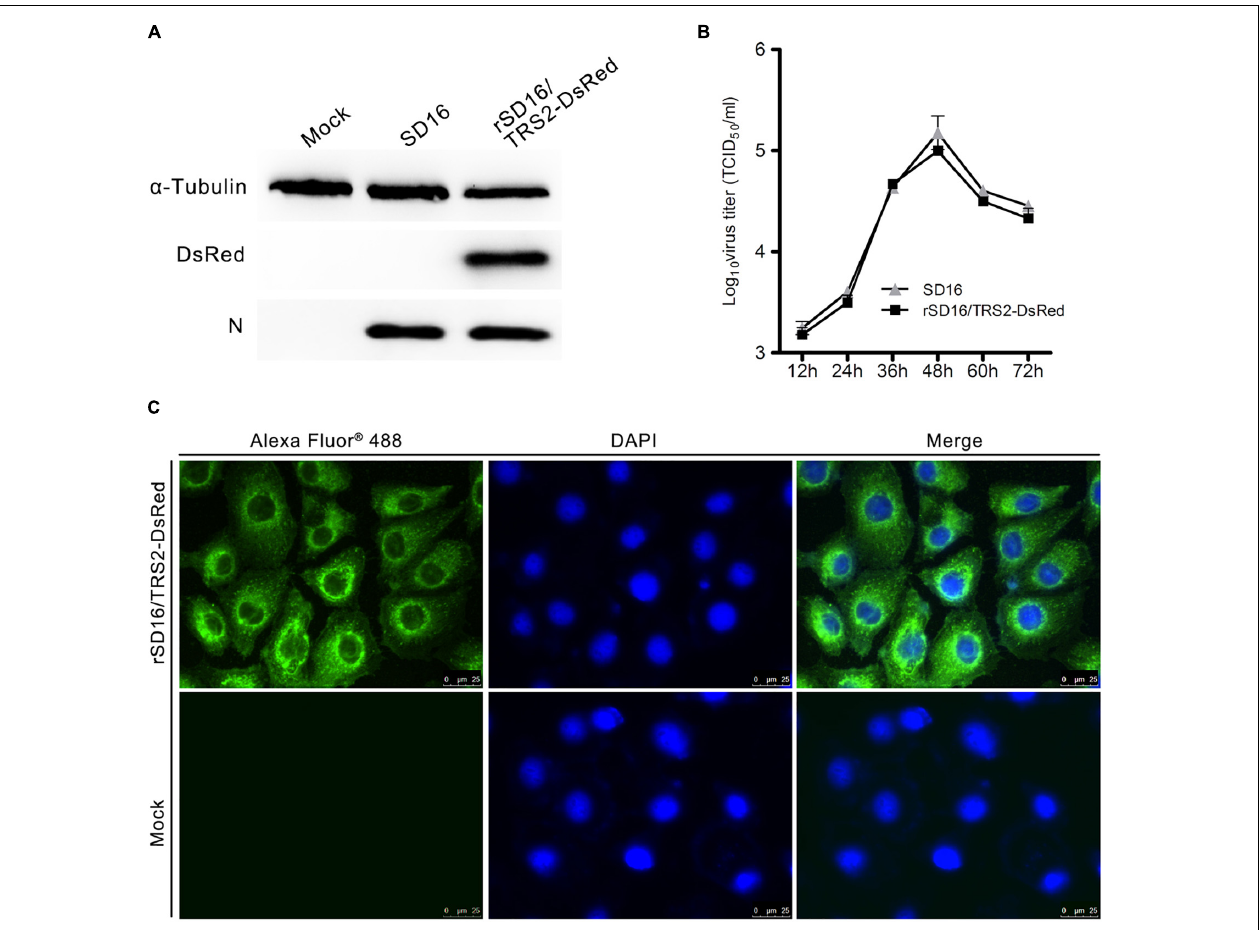
FIGURE 2 | DsRed protein expression and growth curve of rSD16/TRS2-DsRed. (A) After being infected with SD16 or rSD16/TRS2-DsRed (MOI of 0.1) for 36 h, the MARC-145 cells were lysed for the western blot analysis of PRRSV protein and DsRed expression, the MARC-145 cells infected with SD16 and normal MARC-145 cells were taken as the control; (B) MARC-145 cells were infected with SD16 or rSD16/TRS2-DsRed at the MOI of 1.0, and the progeny virus produced in the culture medium was measured at a series of times from 12 to 72 hpi by the method of TCID 50 detection, and all the data were expressed as the mean ± standard deviation (SD); (C) after infected with rSD16/TRS2-DsRed for 48 h, the MARC-145 cells were fixed for the immunofluorescence analysis using the monoclonal antibody of PRRSV N protein, the normal MARC-145 cells were the